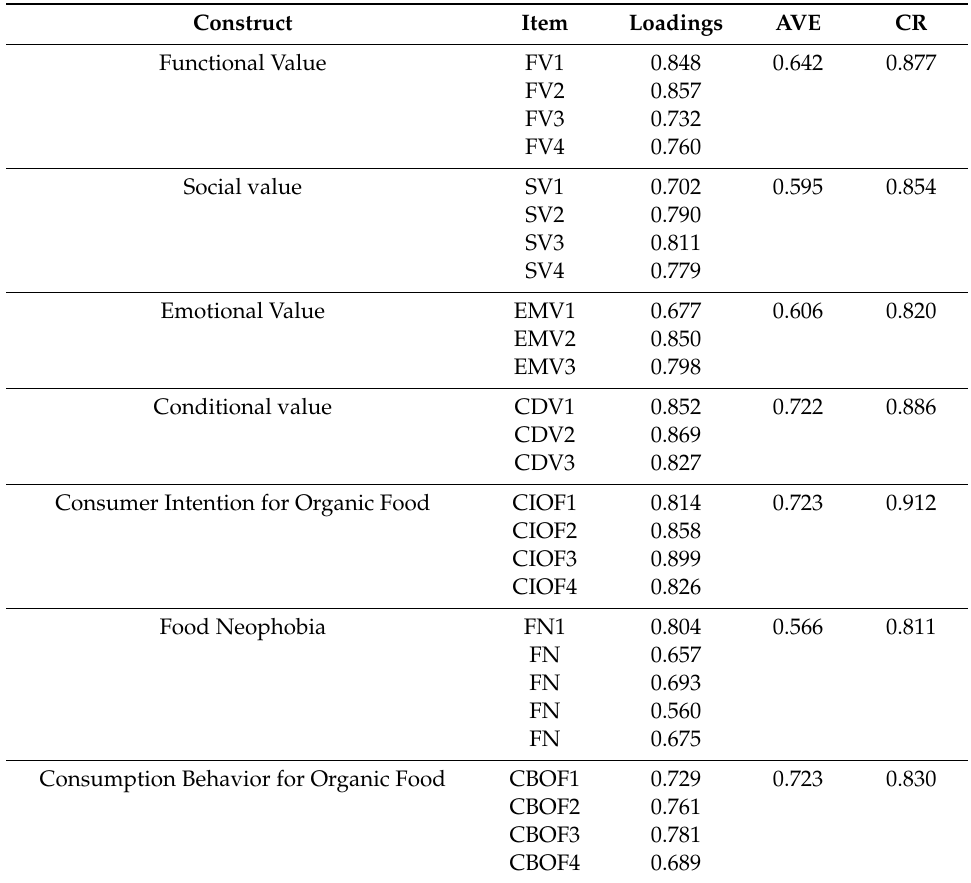
Table 2. Measurement Model Assessment.